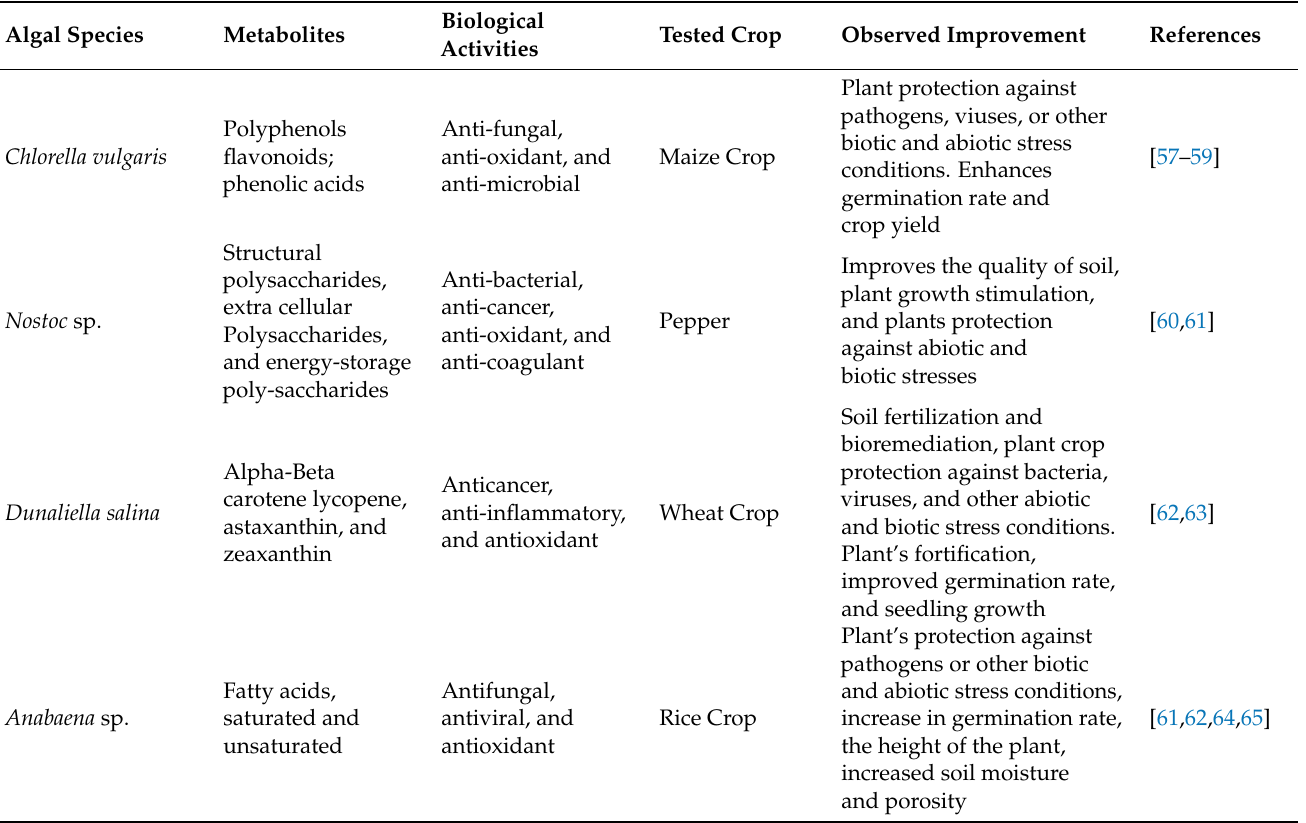
Figure 1. Applications of phycofertilizers in agriculture. Table 1. Algal metabolite impacts on agriculture.